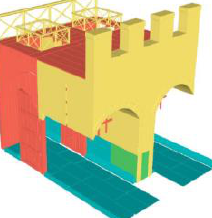
Figure 12. Detail of the double entrance model colorized according to the LoU defined in the Castellum project.